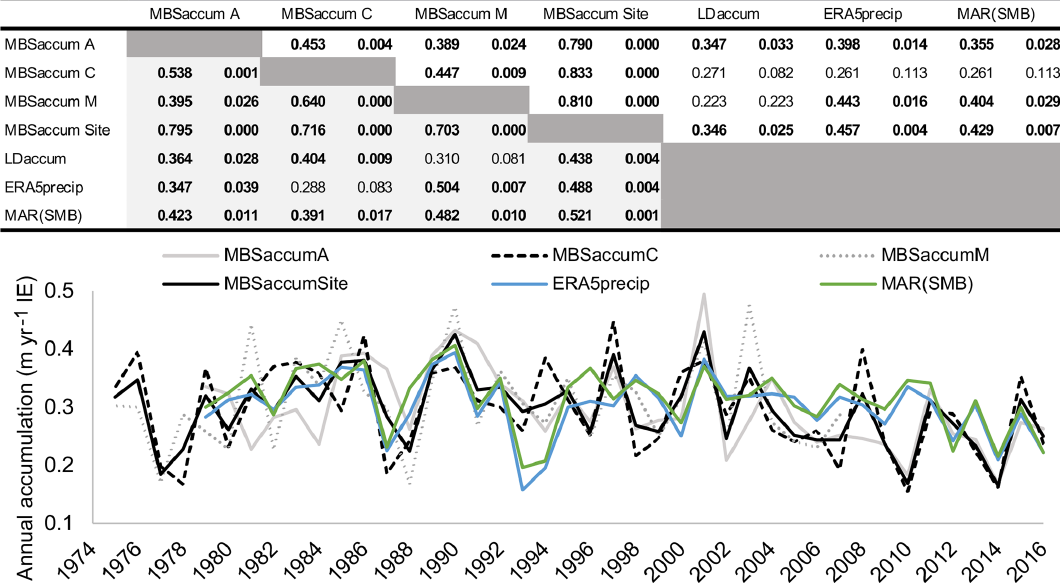
Figure 3. Time series of annual snow accumulation for the Mount Brown South site average (MBSaccumSite); the Alpha (MBSaccumA), Charlie (MBSaccumC), and Main (MBSaccumM) ice cores; and the ERA5 precipitation data from the MBS Main site (ERA5precip). The embedded table shows Pearson’s correlation coefficient ( r : left column; p : right column) for the average annual snow accumulation for MBSaccumSite, MBSaccumA, MBSaccumC, and MBSaccumM and the annual snow accumulation for the Law Dome (Dome Summit South site) record (LDaccum). Correlations using Gaussian-smoothed (kernel = 3 yearly points; σ = 0.6) accumulation time series are shaded and presented in the lower-left of the table. Correlations significant at 95% are bold, and the dates range between 1975 and 2016.